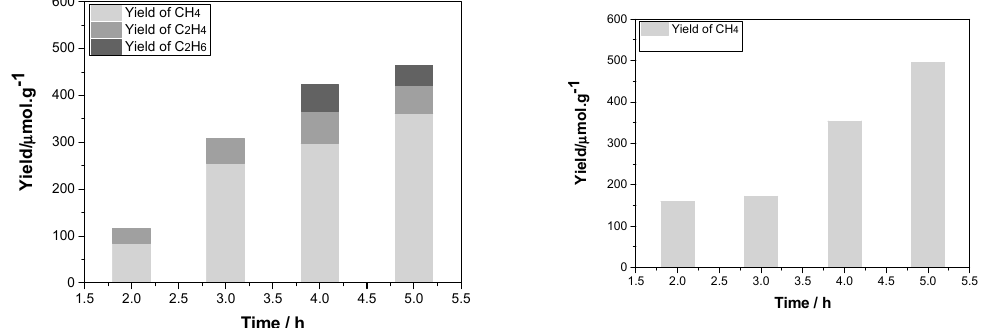
Figure 7. CO 2 photoreduction behavior of pure Bi 2 WO 6 ( left ) and WO 3 ( right ) (natural light, CR = 600). In general, the activity promotion of Bi 2 WO 6 /WO 3 does not stem from the specific